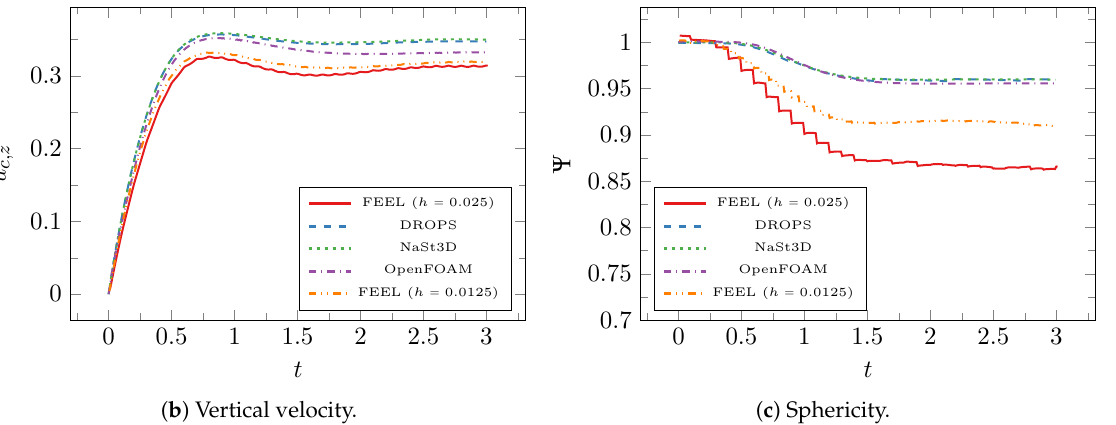
Figure 6. Comparison between our results (denoted FEEL) and the ones from [44] for the test case 2 (the ellipsoidal